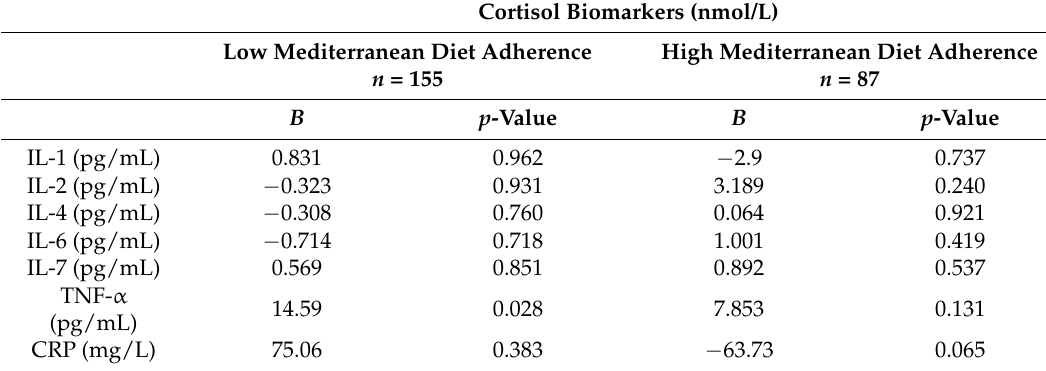
Table 3. Association between cortisol biomarkers (nmol/L) and inflammatory cytokines, according to adherence to adolescent Mediterranean diet score